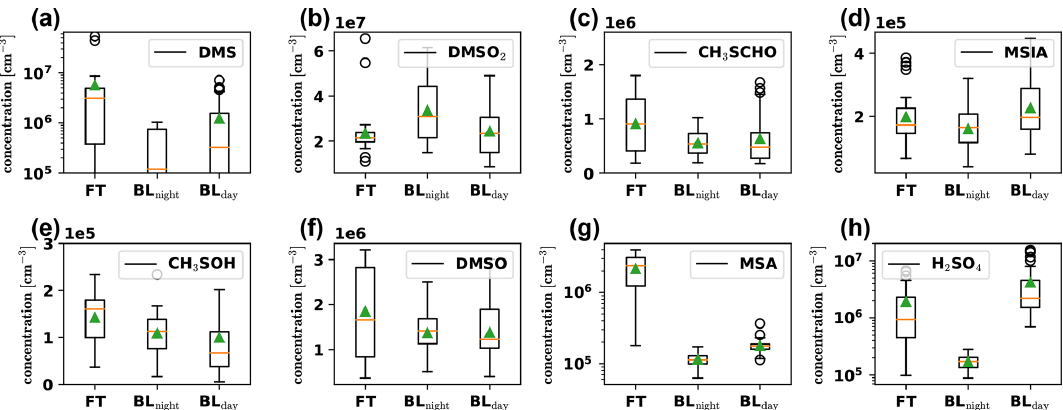
Figure 6. Boxplots of gas-phase DMS oxidation products, detected by the PTR3 and nitrate-CIMS in the FT (free troposphere without boundary layer influence), BL night (within boundary layer during nighttime) and BL day (within boundary layer during daytime) air masses, respectively. The plots are based on 32 data points from averaged 30min intervals each, with nighttime and daytime boundary layer conditions chosen to be as close in time as possible to FT periods with the same prevailing wind direction (horizontal air mass origin) for optimal comparison. The orange line shows the median, and the green triangle shows the mean value of the